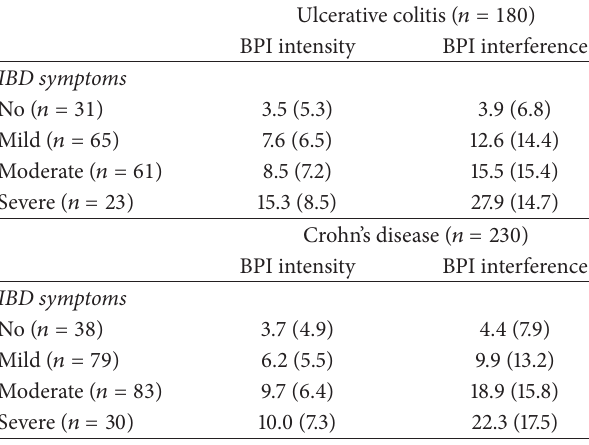
Table 5: Known group validation of BPI scores according to self- assessed symptom burden at baseline.